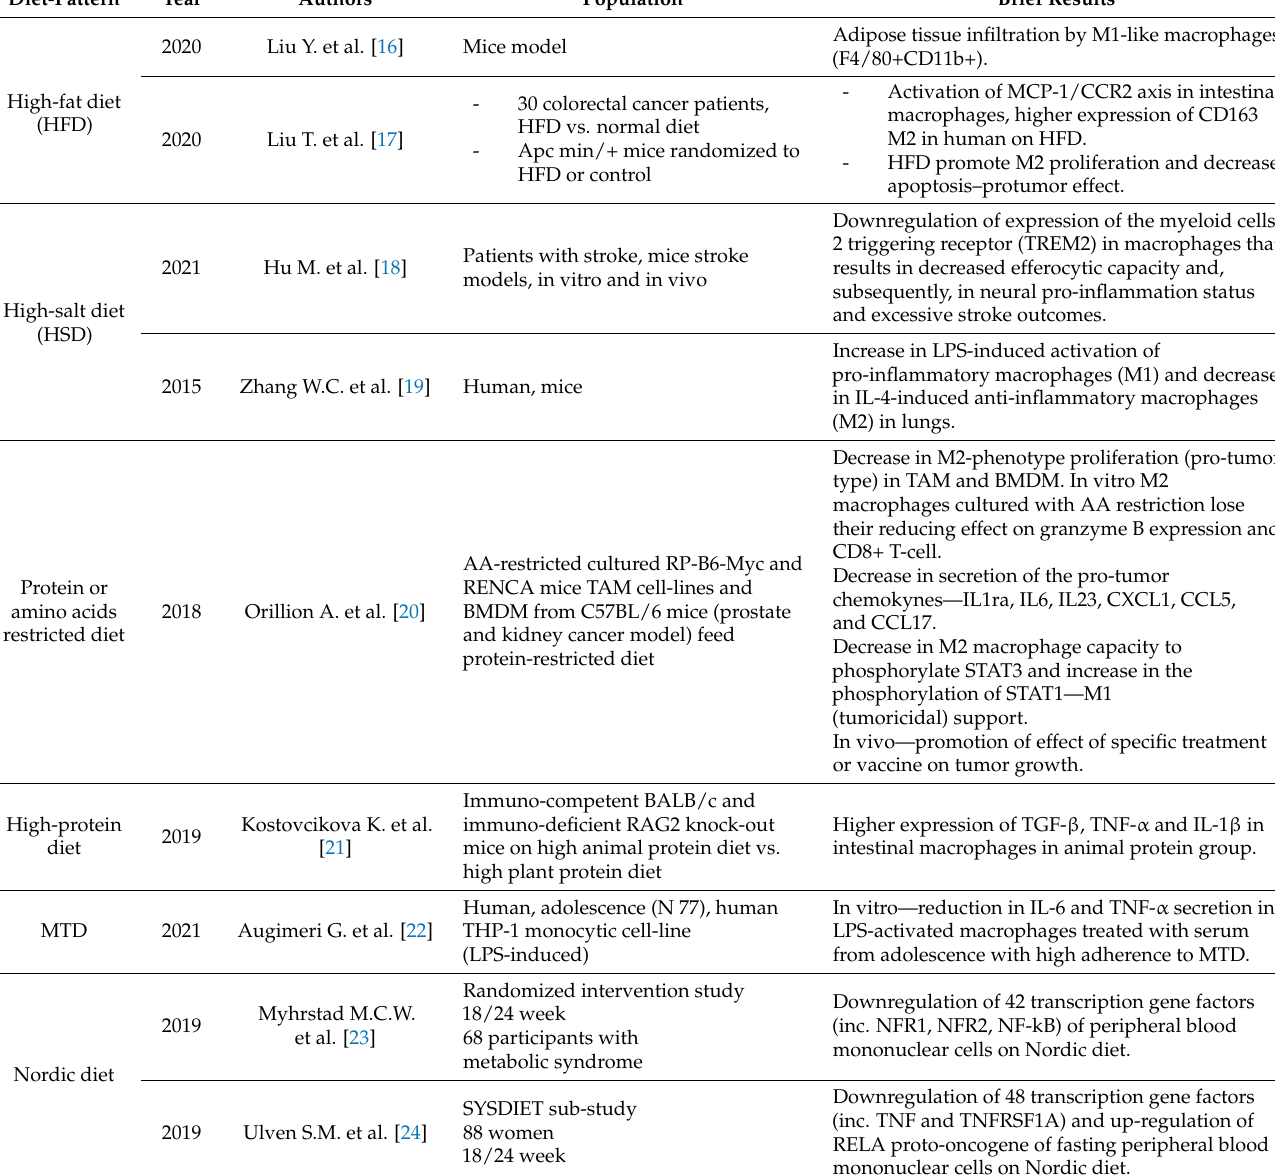
Table 1. Recent studies which investigated the association of diet patterns with macrophage